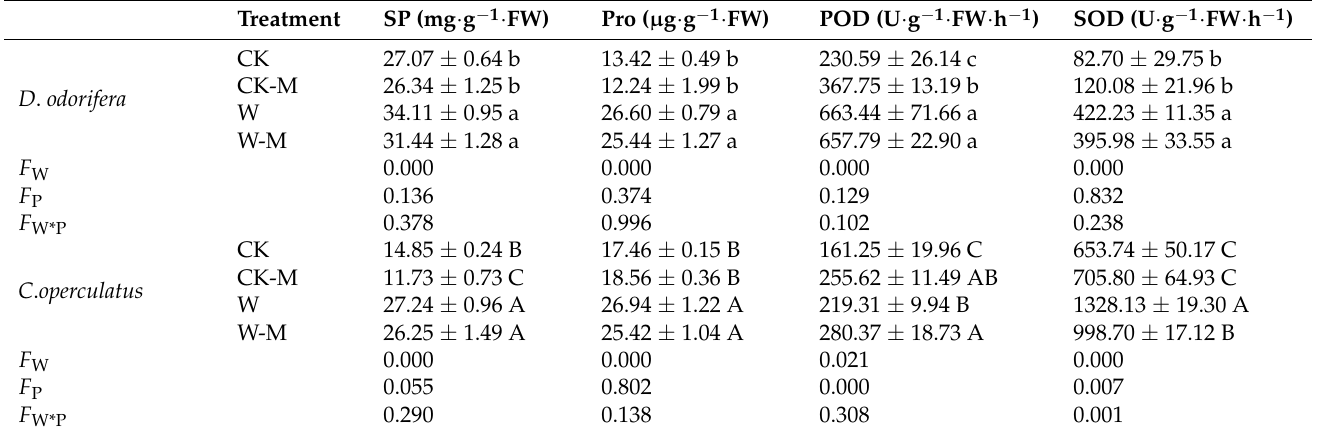
Table 2. Comparative analyses of the contents of soluble protein, free proline, SOD, and POD of C . operculatus and D . odorifera under all